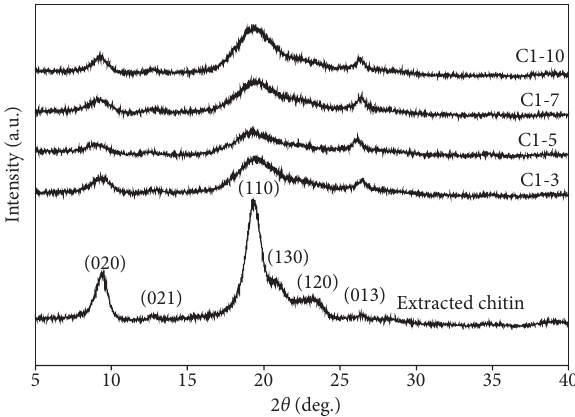
Figure 11: XRD patterns of the extracted chitin and the C1 hydrogel